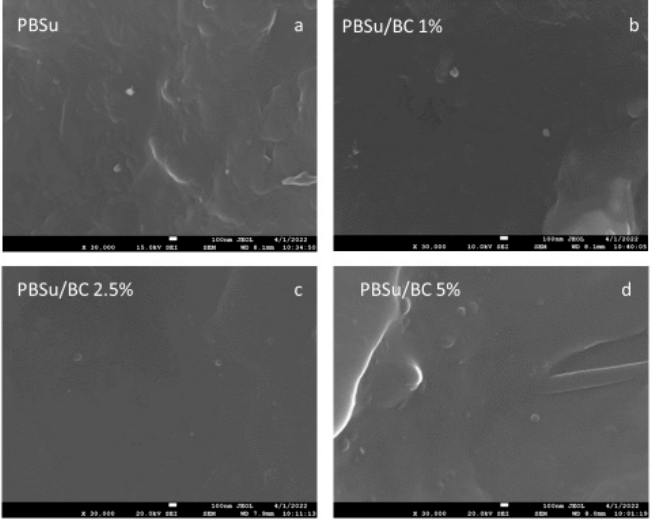
Figure 14. SEM micrographs of the impact fracture surfaces of PBSu/BC composite in high magnifi- cation, for samples indicated on the figure.